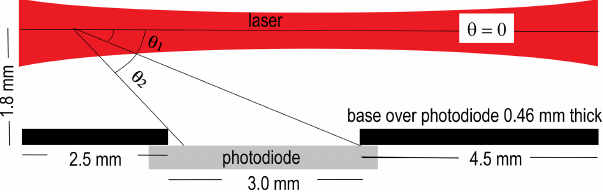
Figure 1. PMS sensor geometry highlighting the dimensions of laser beam (red) and photodiode (gray) and the various relevant dis- tances between the